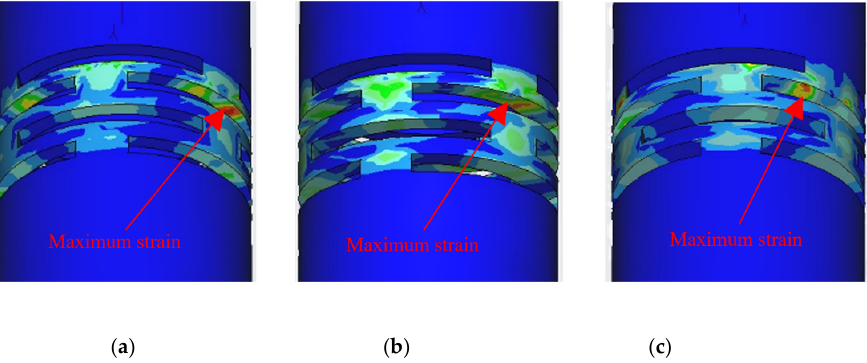
Figure 6. Laser cutting error in relation to the location of the peak hot spot. ( a ) Standard cut, ( b ) cutting error of +0.05 mm, ( c ) cu tt ing error of − 0.05 mm. ( b ) cutting error of +0.05 mm, ( c ) cutting error of − 0.05